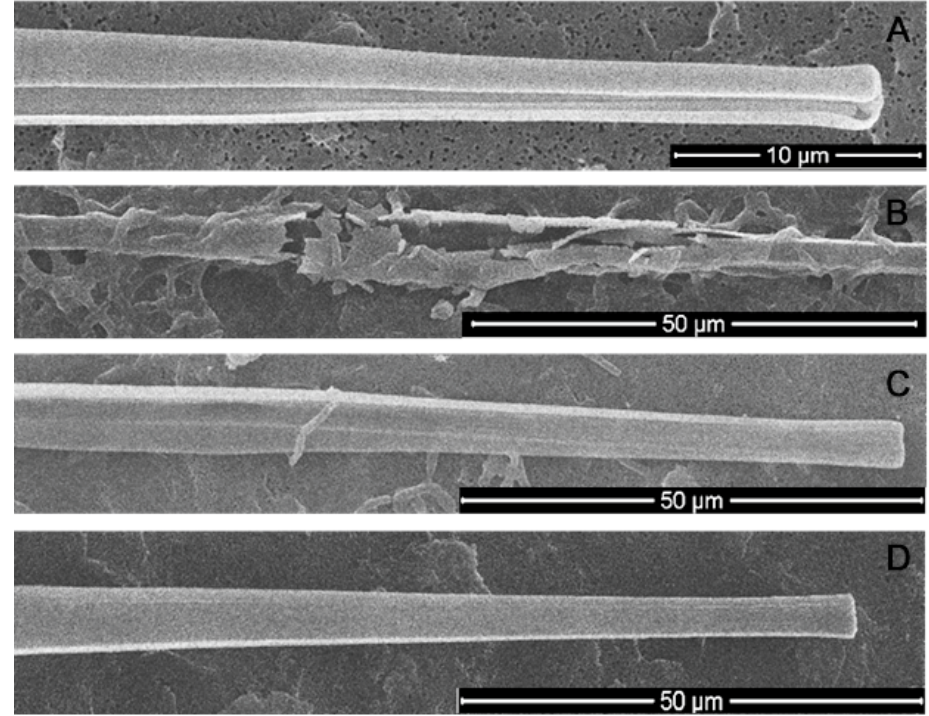
Figure 8. The state of a silicon frustules of U. acus under different conditions. ( A ) axenic culture; ( B , C ) co-culturing with B. mycoides BS2-15 bacterial culture; ( D ) adding of bacterial filtrate to diatoms. It was previously demonstrated that a large proportion of the near-bottom layer of Lake Baikal is composed just by U. acus and diverse bacteria [9]. Because of the vertical water exchange phenomenon, live diatoms can precipitate at the bottom. It was also observed that bacteria from bottom sediments can use the cell wall of U. acus as a carbon source [35], and this corresponds to the observed increase of frustules fragility after